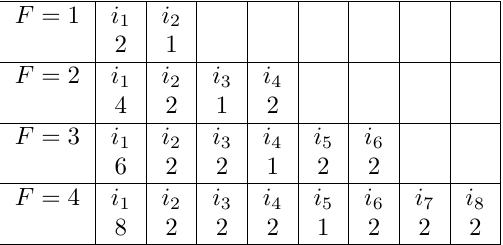
Table 5: Number of Type I harmonics ( N 3 ω